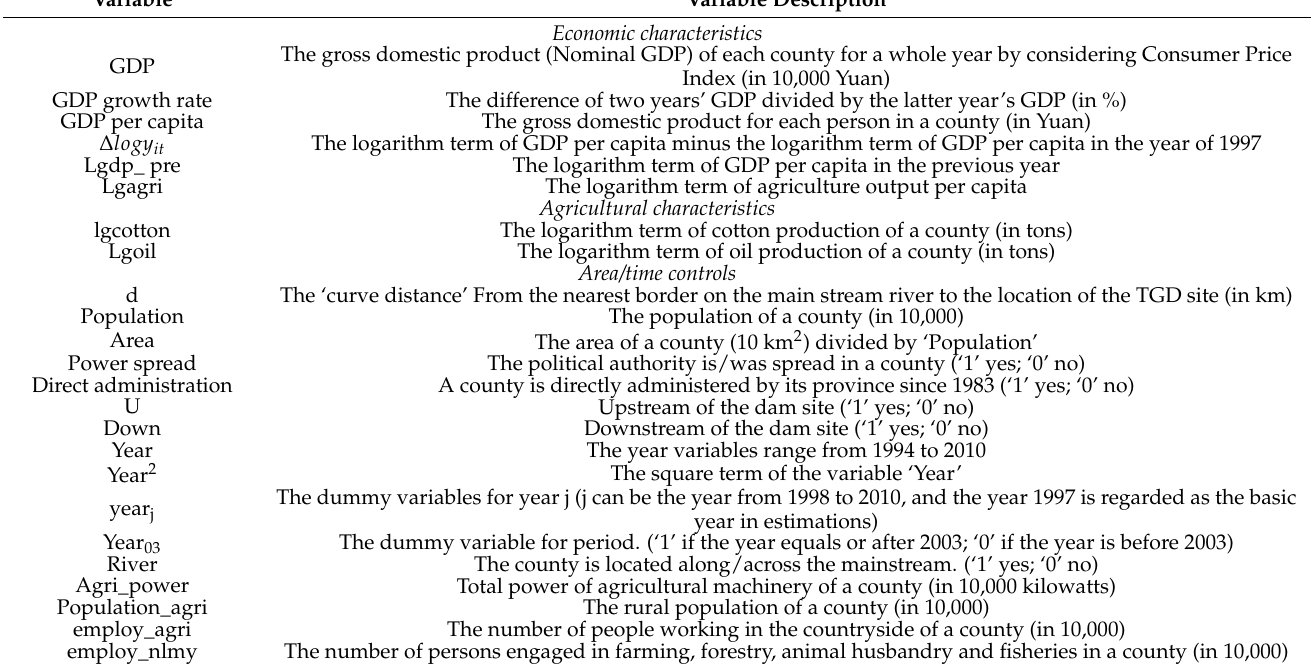
Table 1. Descriptions of the main